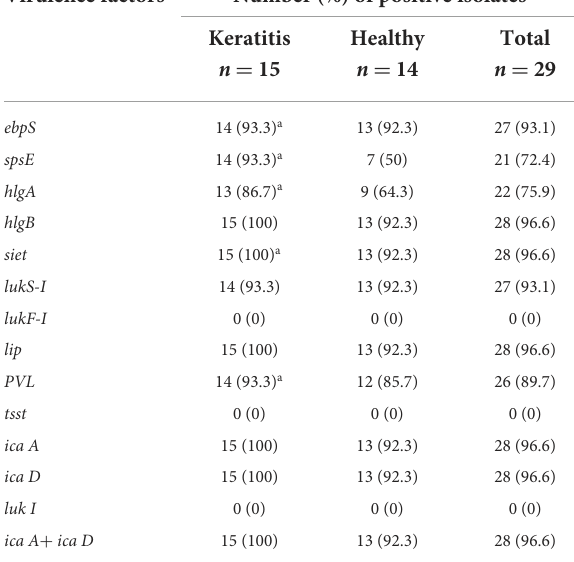
TABLE 5 The MDR patterns of 7 S. pseudintermedius isolates. MDR patterns